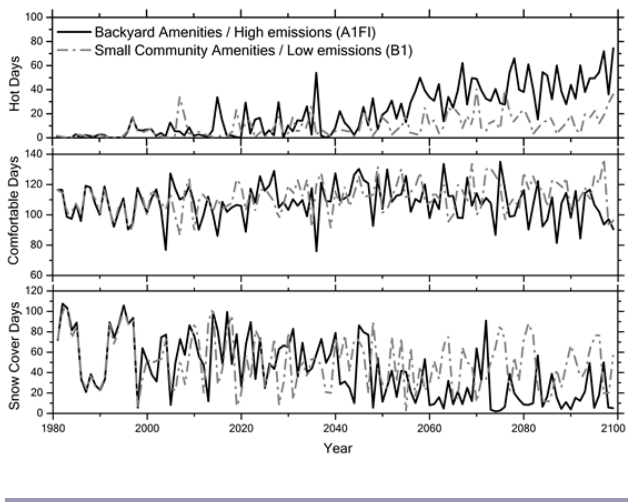
Fig. 5. Time series of climate environmental indicators for Backyard Amenities / High Emissions and Small Community Amenities / Low Emission scenarios through 2100 for (a) Very Hot days (days per year), (b) Comfortable days (days per year), and (c) Snow Cover days (days per year).